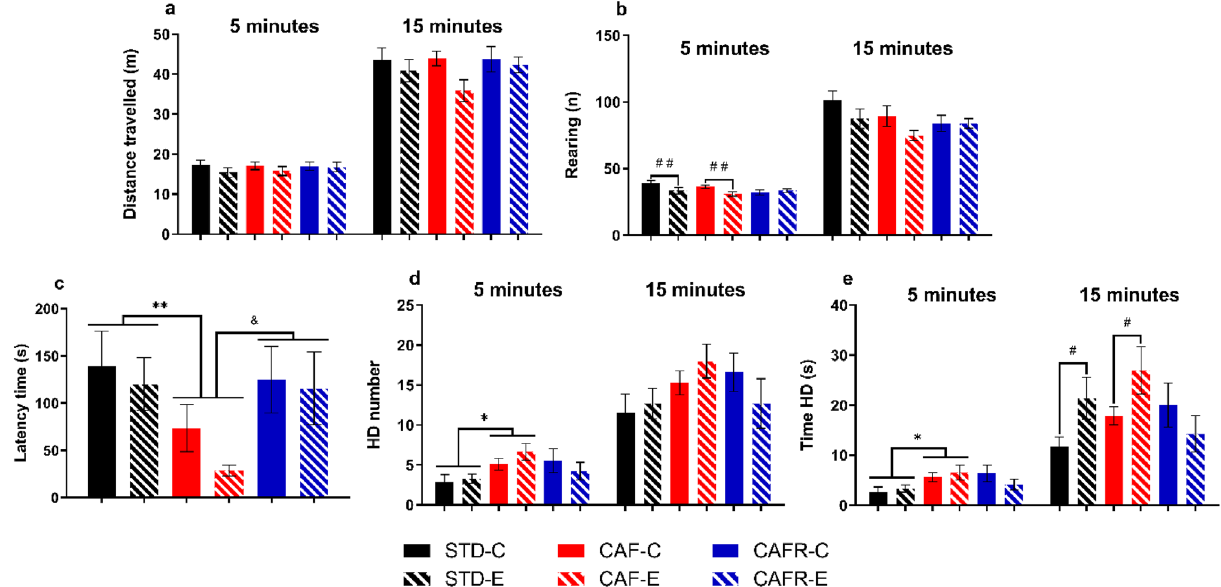
Figure 6. Effects of dietary treatments and exercise on ambulatory and exploratory behavior in the Hole Board test in the first 5 min and the whole 15 min test. ( a ) Distance traveled (m). ( b ) Number of rearings. ( c ) Latency time (seconds) of the first head dip. ( d ) Number of head dips. ( e ) Time spent head-dipping (seconds). Values are mean ± SEM. * p < 0.05, ** p < 0.01 versus STD; & p < 0.05 versus CAF; # p < 0.05, ## p < 0.01 versus the respective non-exercised